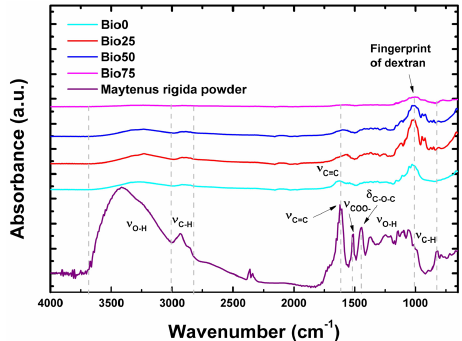
Figure 2. FTIR spectra of Maytenus rigida ponder and EPS-based